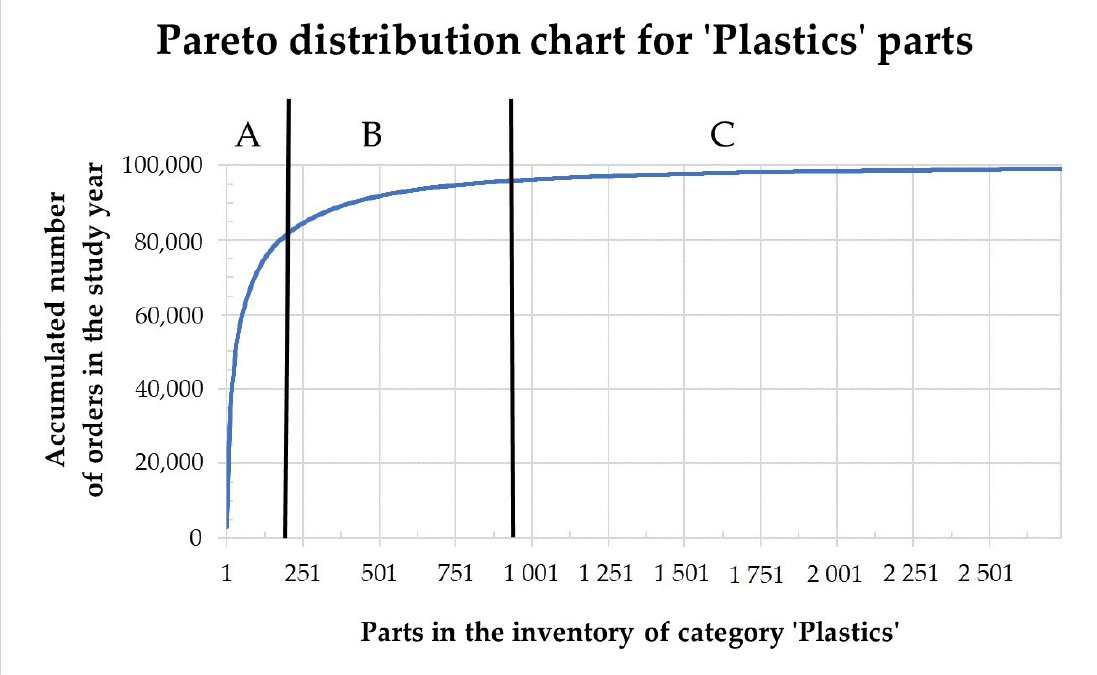
Figure 2. Pareto distribution A-B-C of the orders received for all references within the category ‘Plastics’. Elaborated by the authors from Unistral Recambios data.